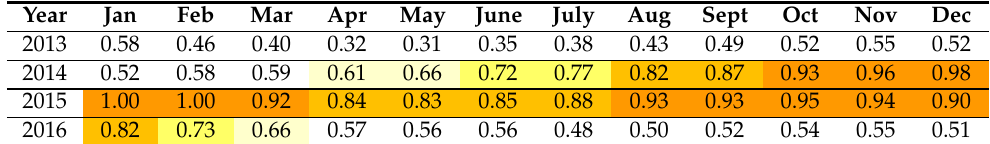
Table 13. Exposure indicator ( ExI 2 )